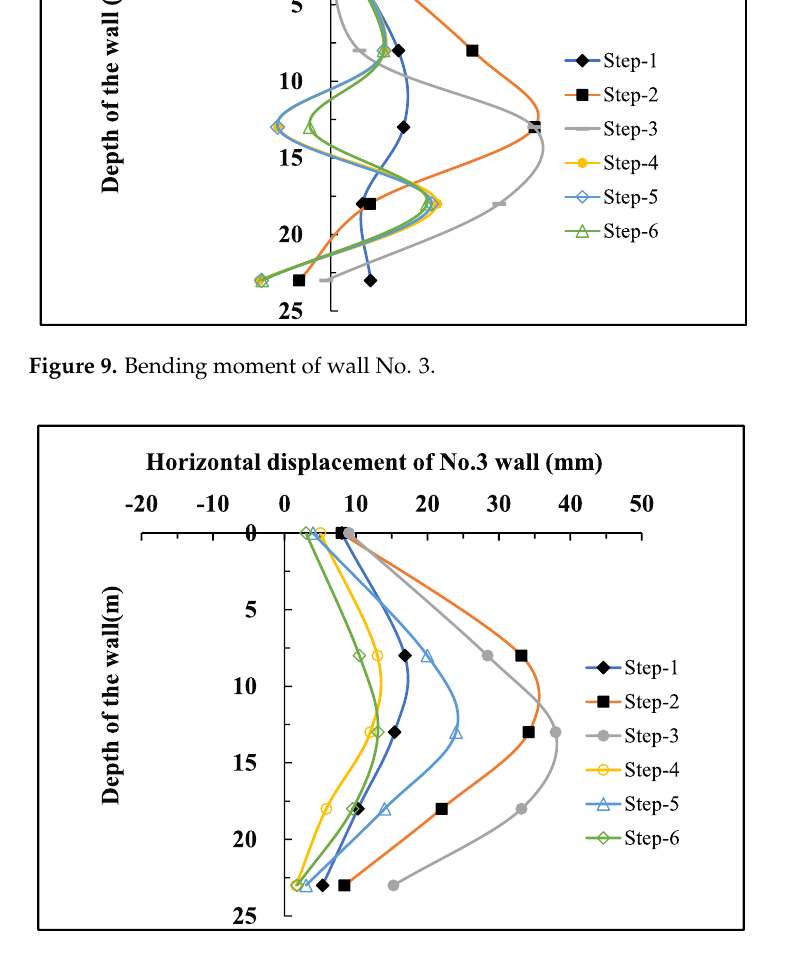
Figure 10. Horizontal displacement of wall No. 3.